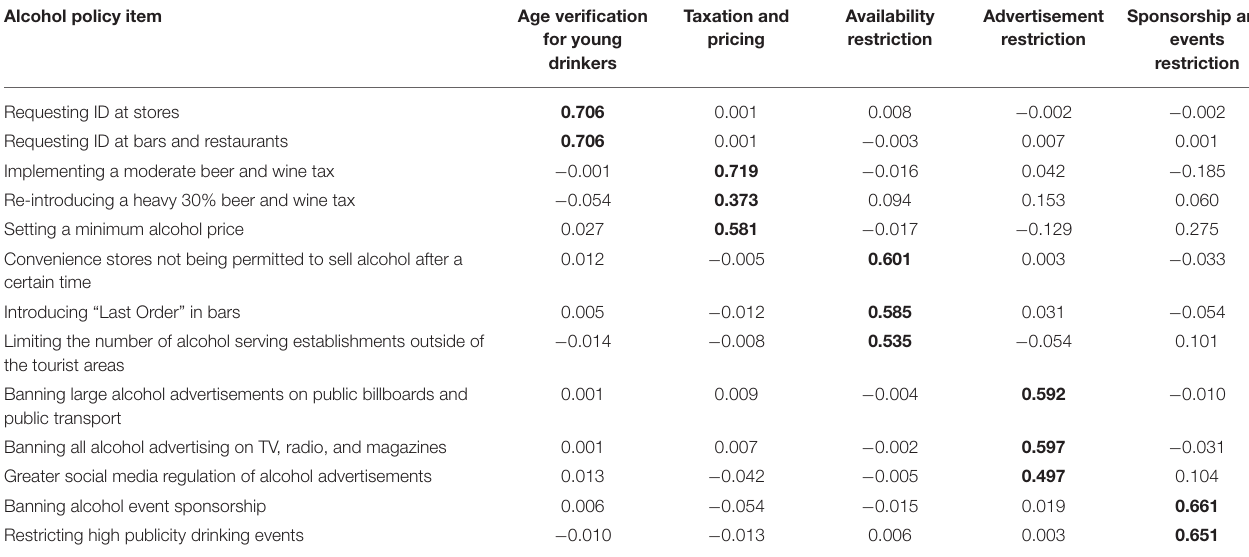
TABLE 3 | Principal component analysis of 13 policy items by five principal components (PCs)–rotated PC